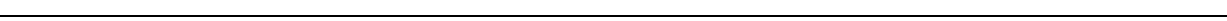
Fig. 5 Constitutive expression of the Ras-MAPK pathway causes overgrowths due to permanent activity of the JNK pathway after irradiation. Images of wing discs of genotypes: a control tubGal80 ts / + ; hh-Gal4/ + ( n = 13), b UAS-Ras V12 /tubGal80 ts ;hh-Gal4/ + ( n = 9) and c tubGal80 ts /UAS-Ras V12 ;hhGal4/ UAS-puc 2A ( n = 11) 72 h after irradiation. Non-irradiated wing discs of genotypes: d control tubGal80 ts / + ; hh-Gal4/ + ( n = 9) and e UAS-Ras V12 /tubGal80 ts ; hh-Gal4/ + ( n = 10). Anterior compartments are stained with Ci (green). JNK activity is monitored by Mmp1 (red). Staining with TOPRO facilitates delimiting the discs. Note in b the large overgrowth of the posterior compartment that contains UAS-Ras V12 , associated with ectopic permanent JNK activity. Much of the overgrowth is prevented ( c ) when JNK function is compromised by overexpressing puc . There is no Mmp1activity (red) in non- irradiated discs ( d , e ). f Quanti fi cation of the posterior compartment area (in percentage) over the total disc area in the genotypes: non-irradiated tubGal80 ts / + ;hh-Gal4/ + control (column: control No X-rays, n = 12), tubGal80 ts /UAS-Ras V12 ;hh-Gal4/ + (column: Ras V12 No X-rays, n = 6), and irradiated tubGal80 ts / + ;hh-Gal4/ + control (column: control X-rays, n = 8), tubGal80 ts /UAS-Ras V12 ;hh-Gal4/ + (column: Ras V12 X-rays, n = 9) and tubGal80 ts /UAS- Ras V12 ;hhGal4/UAS-puc 2A (column: Ras V12 puc X-rays, n = 34). There is a statistically signi fi cant size increase of the posterior compartment after irradiation when Ras V12 is expressed, compared with non-irradiated discs and with irradiated controls (*** p -value < 0.0004, Mann – Whitney U -test). However, if JNK activity is suppressed by overexpressing puc , the size of the posterior compartment signi fi cantly decreases (*** p -value < 0.0001, Mann – Whitney U -test). Columns in the graph represent mean ± s.d. Images of wing discs of genotypes: g STAT-GFP/tubGal80 ts ;UAS-Ras V12 /hh-Gal4 ( n = 20) and h UAS-GFP,tubGal80 ts /UAS-Ras V12 ;hh-Gal4/ + ( n = 9) 72 h after irradiation; g shows the ectopic expression of STATGFP (green) only in the posterior compartment (delimited by the lack of Ci in red) where Ras V12 is expressed; h shows the ectopic expression of Wg (red) only in the posterior compartment (green) where Ras V12 is active. Scale bars are 100 μ